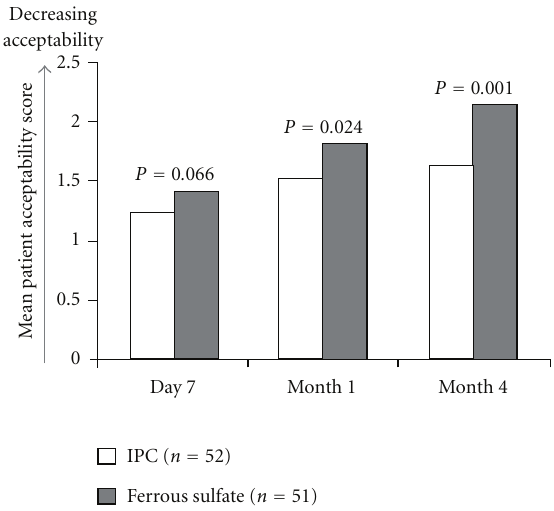
Figure 1: Acceptability score in pediatric patients with iron defi- ciency anemia receiving oral iron therapy in the form of iron hydroxide polymaltose complex (IPC) or ferrous sulfate. Accept- ability was assessed using the Wong-Baker scale [15], on which a “happy face” (score 0) stands for no di ffi culties, while a “sad face” (score 5) indicates that the child refused or was forced to take the